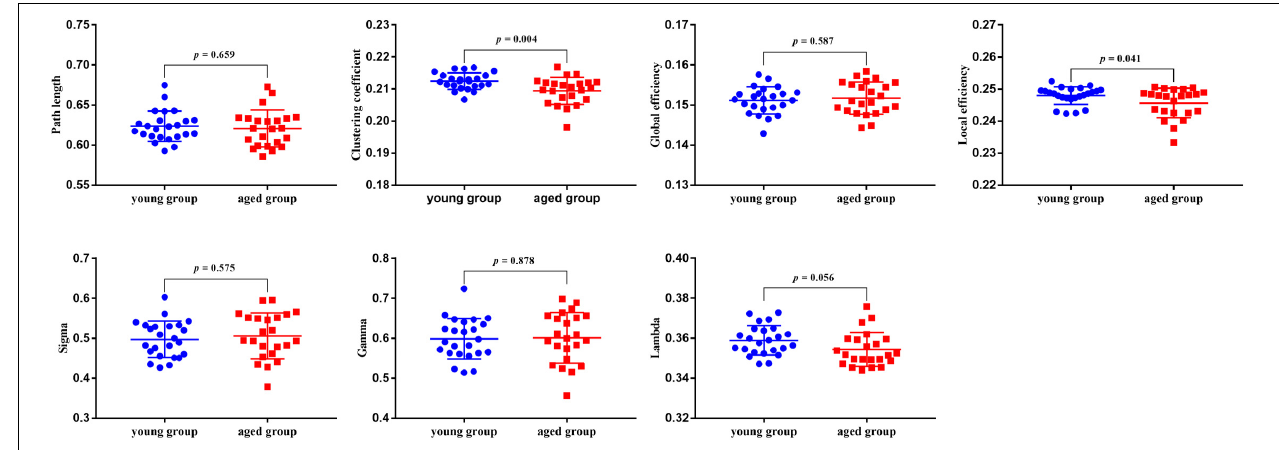
FIGURE 1 | The results of global properties between the young rats and aged rats. And p < 0.05 indicates significant differences.